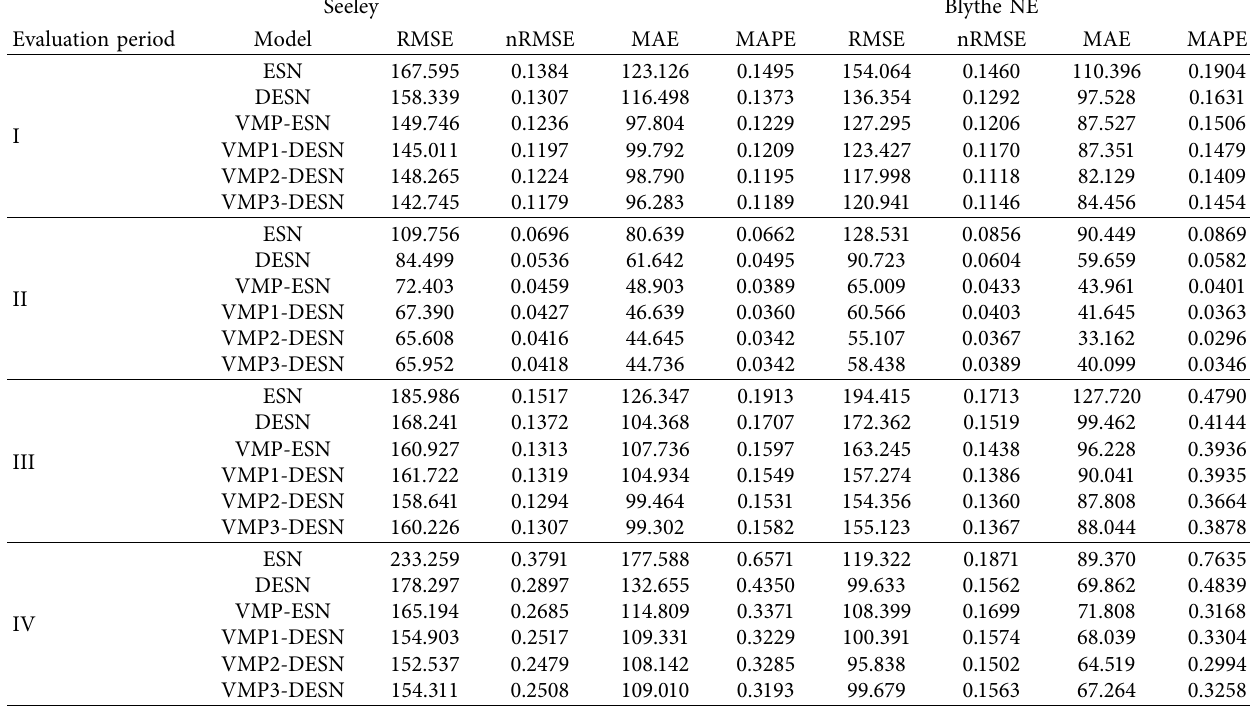
Table 4: Statistical results comparison of different prediction models for Seeley and Blythe NE stations. Seeley Blythe NE